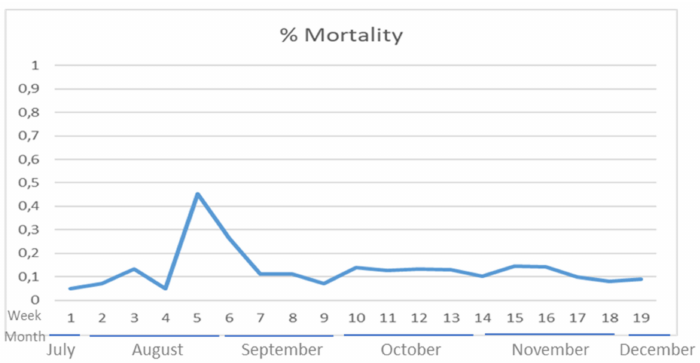
Figure 2. Percentage of weekly mortality on the farm during the observation